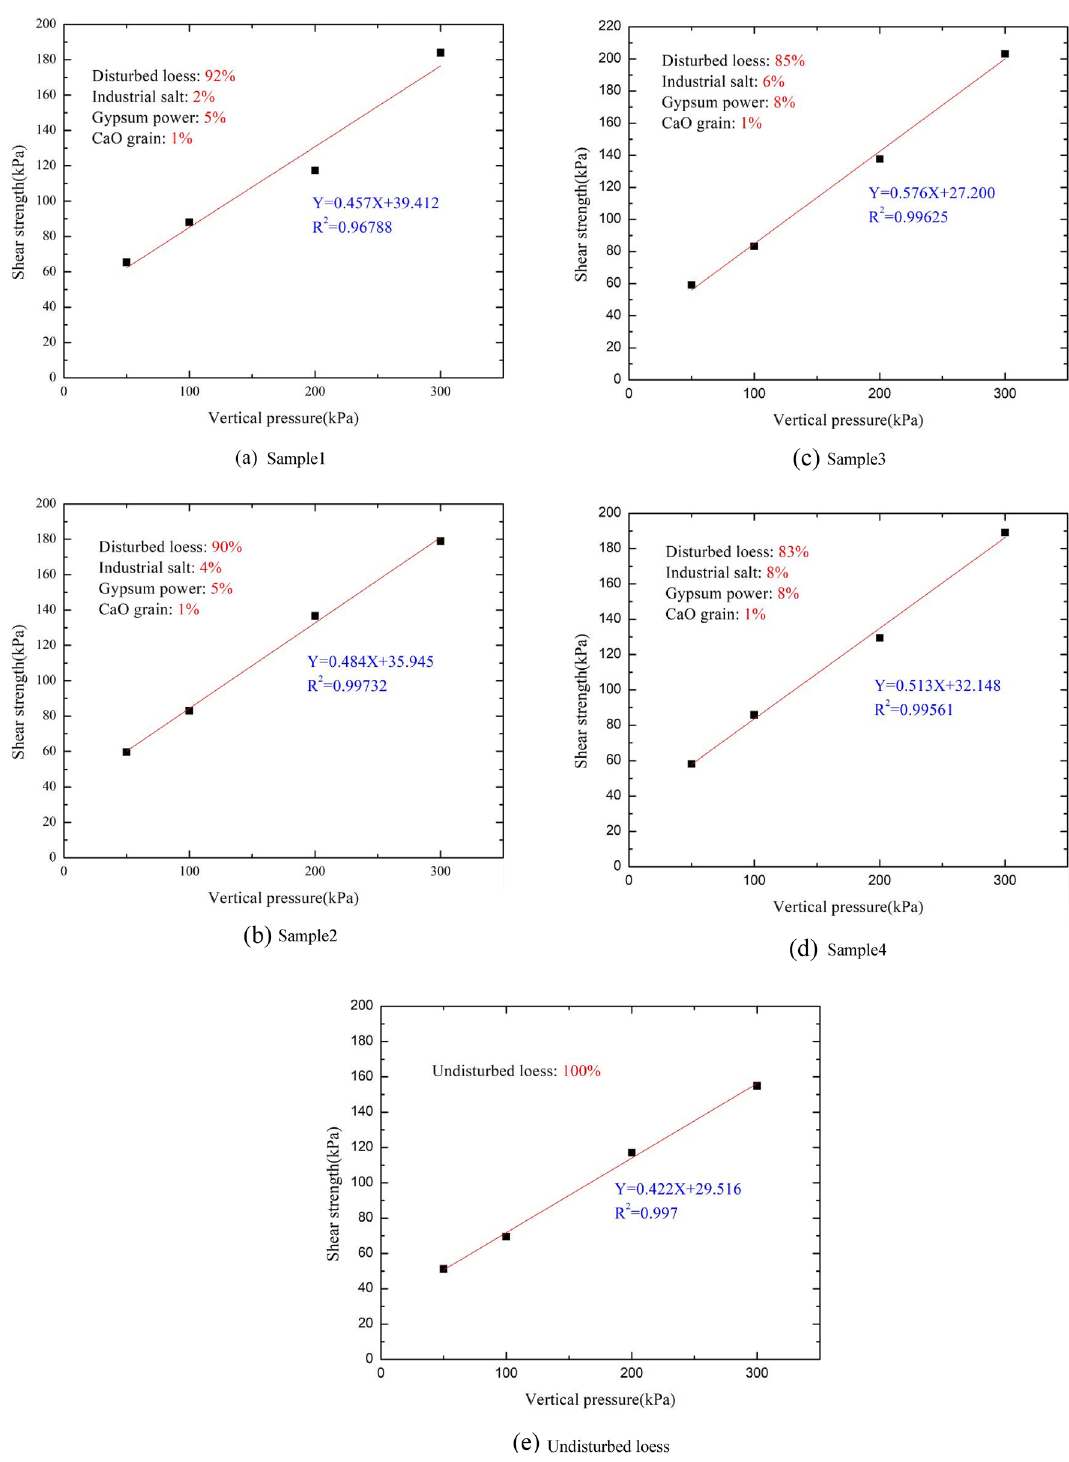
Figure 4. Results of direct sheer